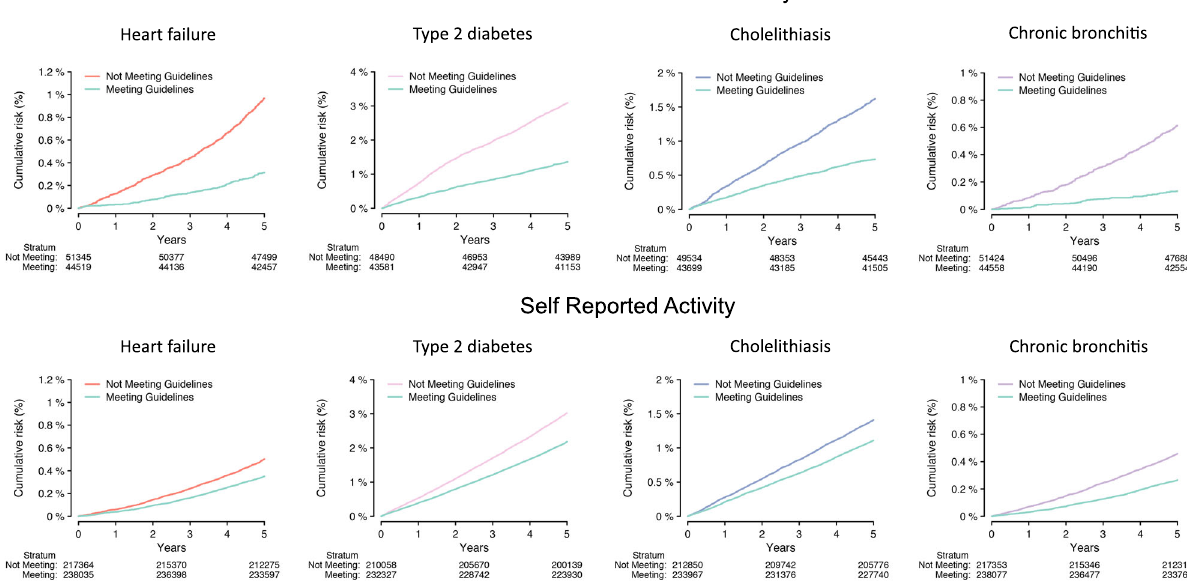
Fig. 3 Cumulative risk of disease strati fi ed by guideline-adherent physical activity. Depicted is the 5-year cumulative risk of heart failure, type 2 diabetes, cholelithasis, and chronic bronchitis, strati fi ed guideline-adherent activity according to accelerometer-measured moderate- to-vigorous physical activity (MVPA, top panels) and self-reported MVPA (bottom panels). In each plot, individuals are grouped into binary categories according to the guideline-based threshold of ≥ 150 min of MVPA/week. Red, pink, blue, and purple strata represent individuals meeting guideline-based levels, and the teal stratum represents individuals not meeting guideline-based levels 1,10,11 . In each plot, the number remaining at risk over time is depicted below. Representative diseases were selected from the four categories having the greatest enrichment for associations with activity, where each disease was signi fi cantly associated with both accelerometer-measured and self-reported activity at a false discovery rate of